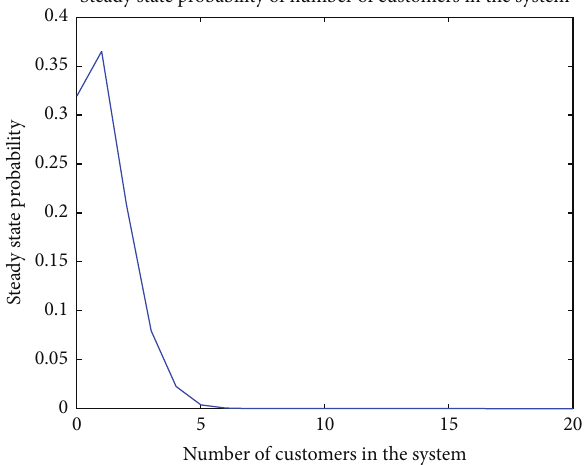
Figure 2: [𝐶 = 2, 𝜆 = 1/35, 𝜇 1 = 1/40, 𝜇 2 = 1/30, 𝜇 = = 5, 𝐾 = 7] 1/20, 𝐾 1 2